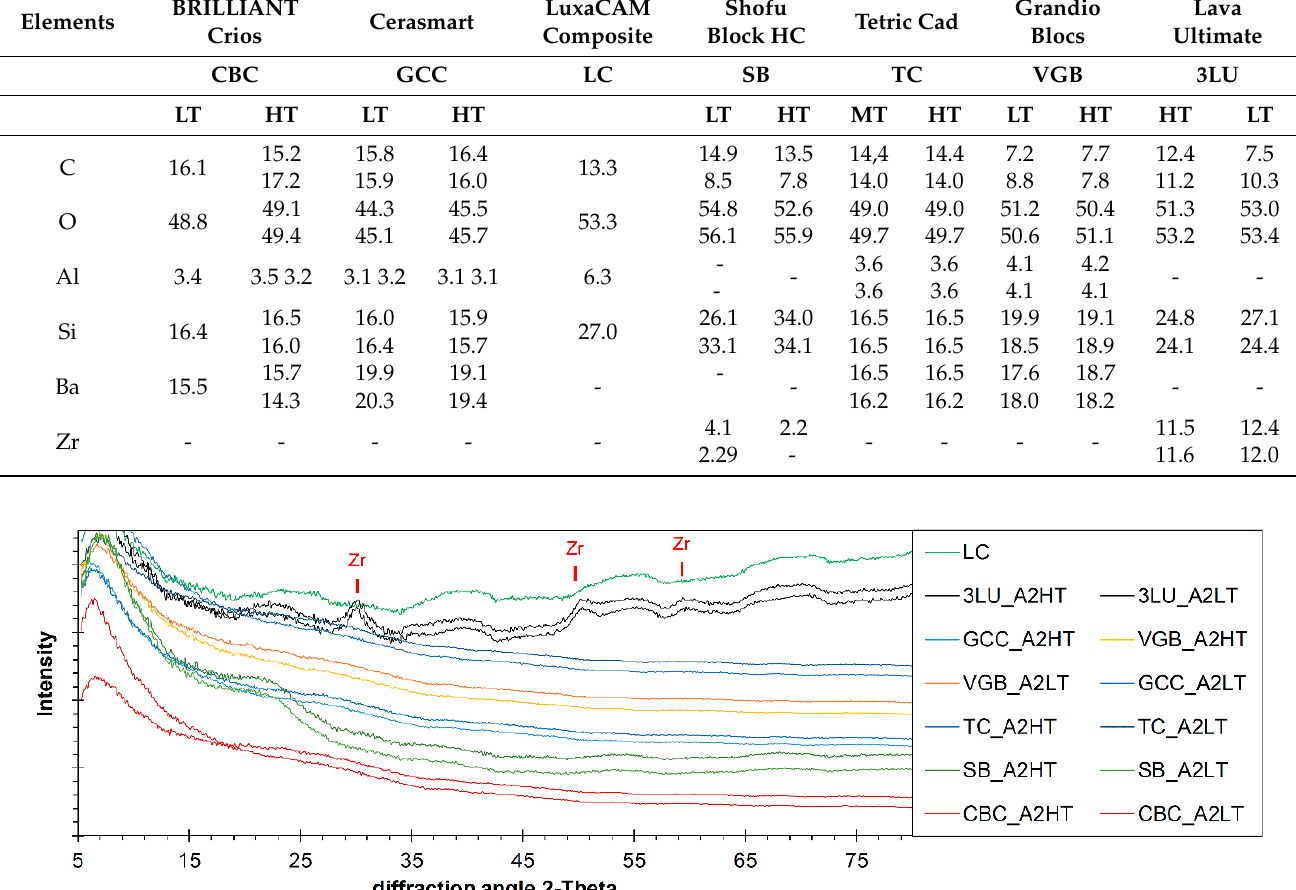
Table 5. Chemical composition of the filler particles (wt%. the CAD/CAM RBCs) analysed. Elements